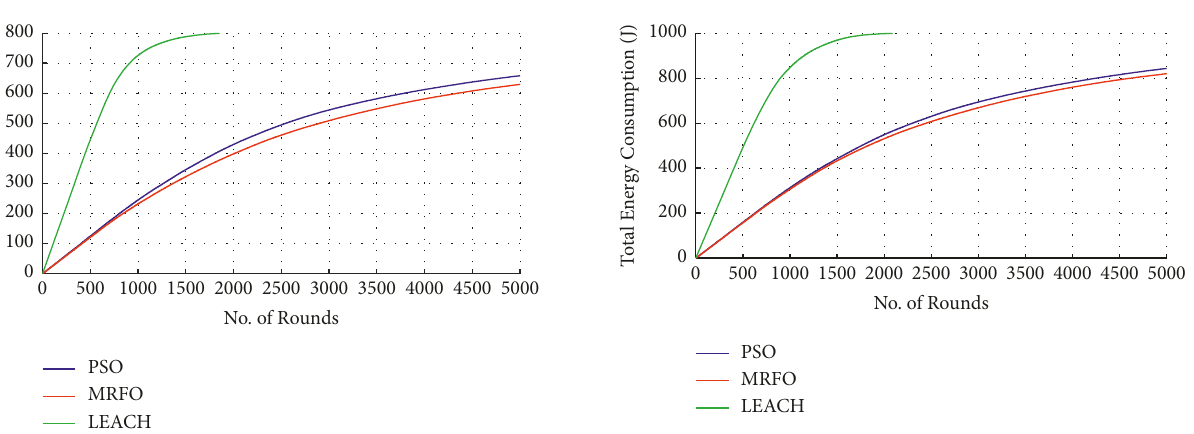
Figure 13: Total energy consumption for 400-node network, 40 CHs when the BS is at the corner of ROI.